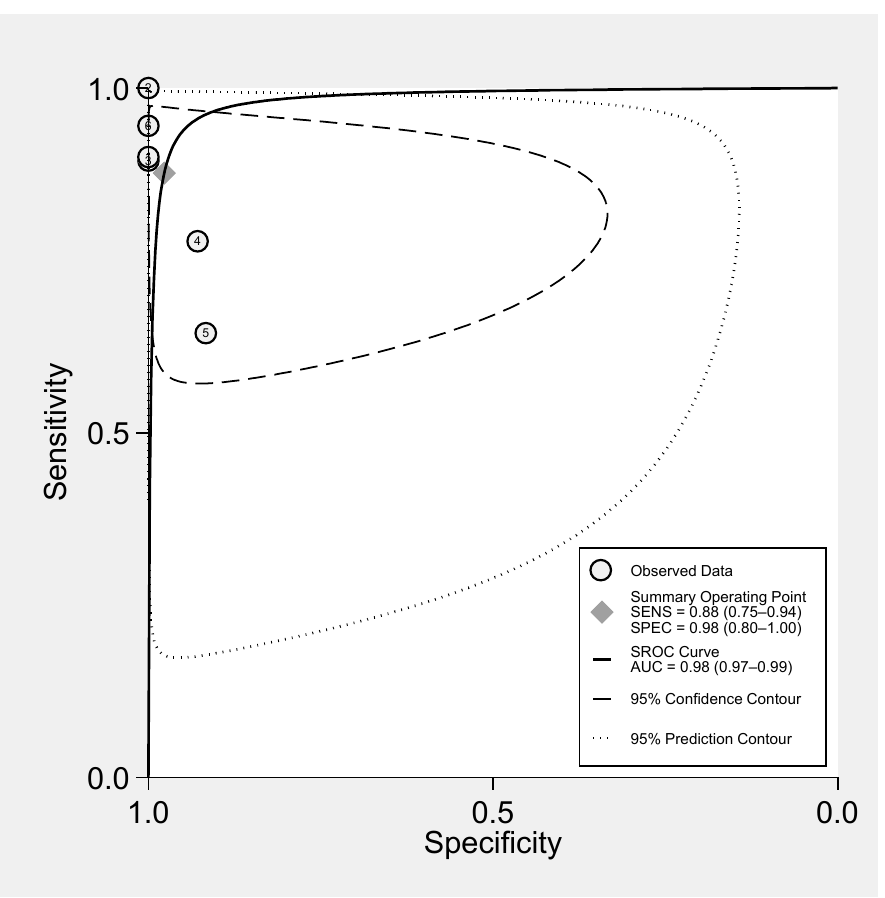
Figure 4. SROC curve of the performance of FNAC in the evaluation of gallbladder masses.